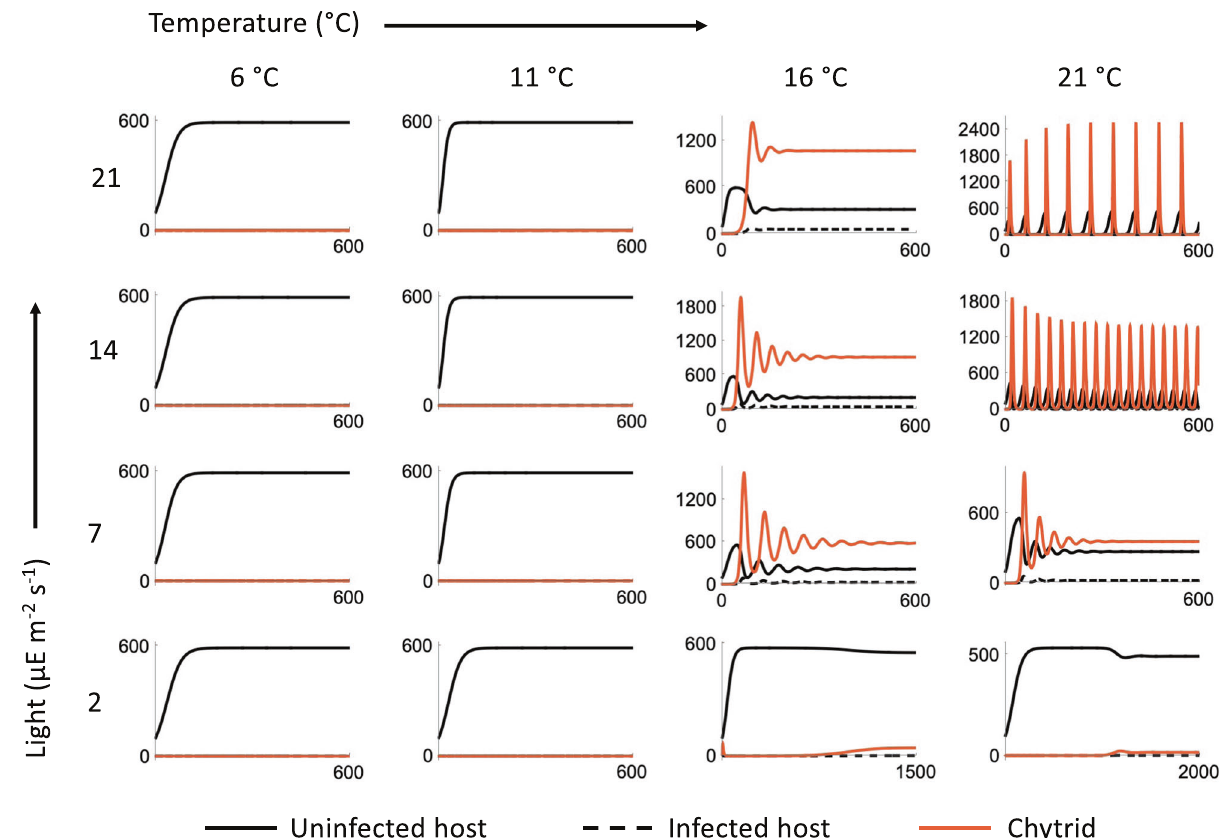
Fig. 4 Example dynamics from the P. rubescens – chytrid model (summarized in Fig. 3), at the parameter combinations we measured experimentally. The solid and dashed black lines indicate uninfected and infected host densities respectively, while the red line indicates the chytrid density. At low temperatures, P. rubescens has a thermal refuge and its density reaches the carrying capacity. With increasing light and temperature there is a shift from stable coexistence (16 °C with 7, 14, 21 μ E m − 2 s − 1 , and 21 °C with 7 μ E m − 2 s − 1 ) to limit cycles (21 °C with 14, 21 μ E m − 2 s − 1